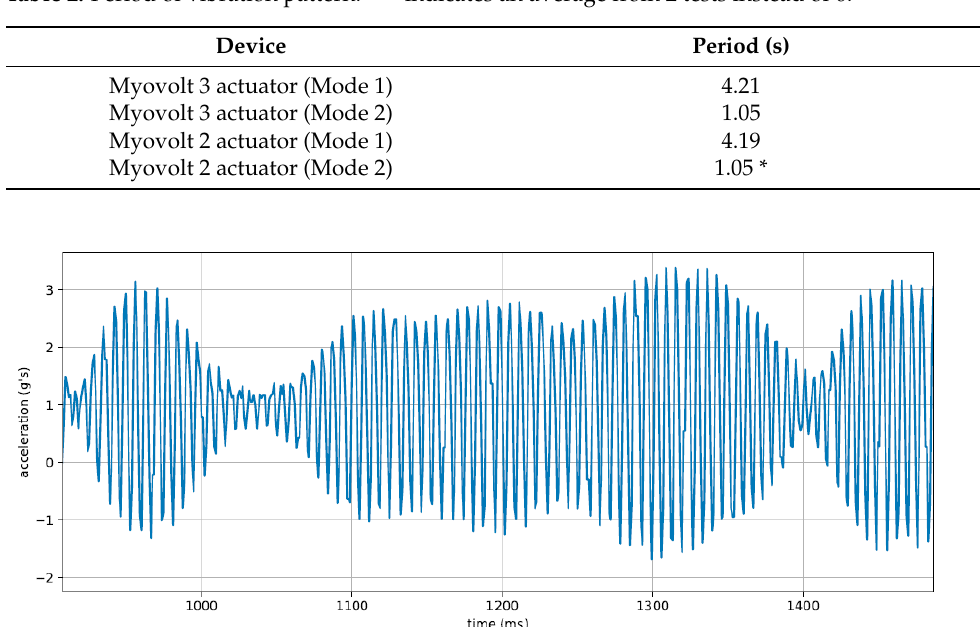
Table 2. Period of vibration pattern. “*” indicates an average from 2 tests instead of 6.